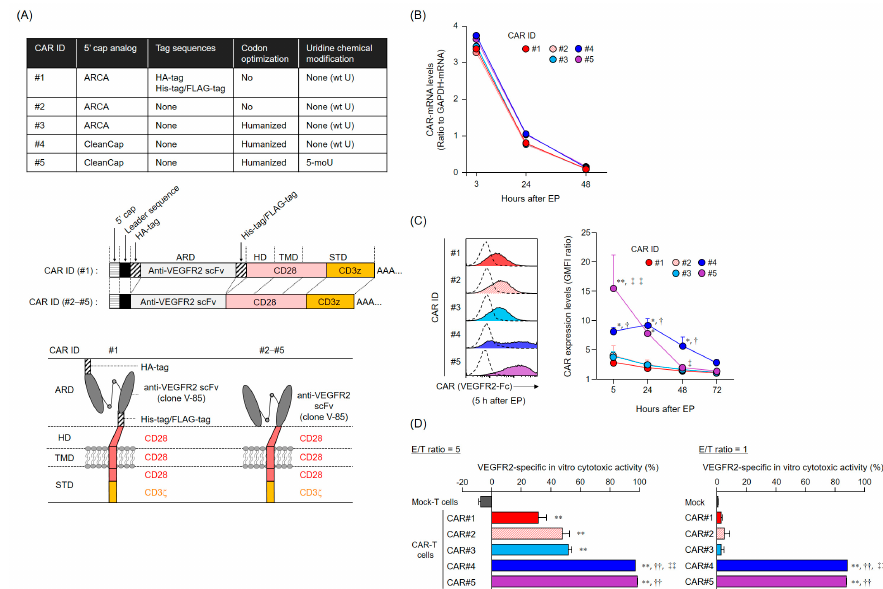
Figure 1. Chimeric antigen receptor (CAR) expression profile and vascular endothelial growth factor receptor 2 (VEGFR2)-specific cytotoxic activity of human T cells transfected with CAR-mRNA variants using electroporation (EP). ( A ) List of CAR constructs used in this study. The upper table shows the details of the five VEGFR2-specific CAR [V / 28 / 28 / 28-3z]-mRNA constructs, with respect to modified 5’ cap structure, tag sequences, codon optimization, and uridine chemical modification. For these CARs, an illustration of CAR-mRNA is shown in the middle panel and an illustration of CAR proteins is shown in the bottom panel. Abbreviations: ARCA, anti-reverse cap analog; ARD, antigen recognition domain; HD, hinge domain; STD, signal transduction domain; TMD, transmembrane domain; wt U, wild type uridine; 5-moU, 5-methoxyuridine. ( B ) Profile of CAR-mRNAs introduced into human T cells. CAR-mRNAs introduced into human T cells were analyzed using reverse transcription-quantitative polymerase chain reaction. CAR-mRNA expression is represented, relative to that of glyceraldehyde 3-phosphate dehydrogenase (GAPDH)-mRNA. The data are shown as the mean ± standard deviation (SD) of triplicates and are representative of at least two independent experiments using di ff erent donor-derived T cells. Statistical analysis was performed using the Dunnett’s test for multiple comparisons with CAR#1 and showed no significant di ff erences. ( C ) Expression profiles of CAR [V / 28 / 28 / 28-3z] proteins on T cell membranes, translated from the di ff erent CAR-mRNA constructs. CAR protein expression was analyzed using flow cytometry using VEGFR2-Fc chimera / anti-human IgG antibody (solid color histograms) or anti-human IgG antibody only (dashed white histograms). CAR expression levels are given using the ratio between VEGFR2-Fc chimera / anti-human IgG staining-geometric mean fluorescence intensity (GMFI) and anti-human IgG antibody staining-GMFI. The histograms on the left are representative results of CAR expression levels, obtained 5 h after EP. The data on the right shows the mean ± SD of three individual experiments using di ff erent donor-derived T cells. Statistical analysis was performed using the Tukey’s test: * p < 0.05 and ** p < 0.01, CAR#4 and CAR#5 versus CAR#1; † p < 0.05, CAR#4 versus CAR#3; ‡ p < 0.05 and ‡‡ p < 0.01, CAR#5 versus CAR#4. (D) VEGFR2-specific in vitro cytotoxic activity of T cells transfected with the di ff erent CAR-mRNA constructs. Human CAR-T cells, cultured for 24 h after EP, were co-cultured with L1.2 cells and VEGFR2 + L1.2 cells at e ff ector cell / target cell (E / T) ratios of 5 or 1 for 18 h. Then, the number of L1.2 and VEGFR2 + L1.2 cells in the wells was evaluated using flow cytometry and the VEGFR2-specific cytotoxic activity was calculated from the ratio of the number of VEGFR2 + L1.2 cells to the number of L1.2 cells. The data are represented as the mean ± SD of the three individual experiments using di ff erent donor-derived T cells. Statistical analysis was performed using the Tukey’s test: ** p < 0.01, CAR-T cells versus mock-T cells; †† p < 0.01, CAR#4-T cells and CAR#5-T cells versus CAR#1-T cells; ‡‡ p < 0.01, CAR#4-T cells versus CAR#3-T